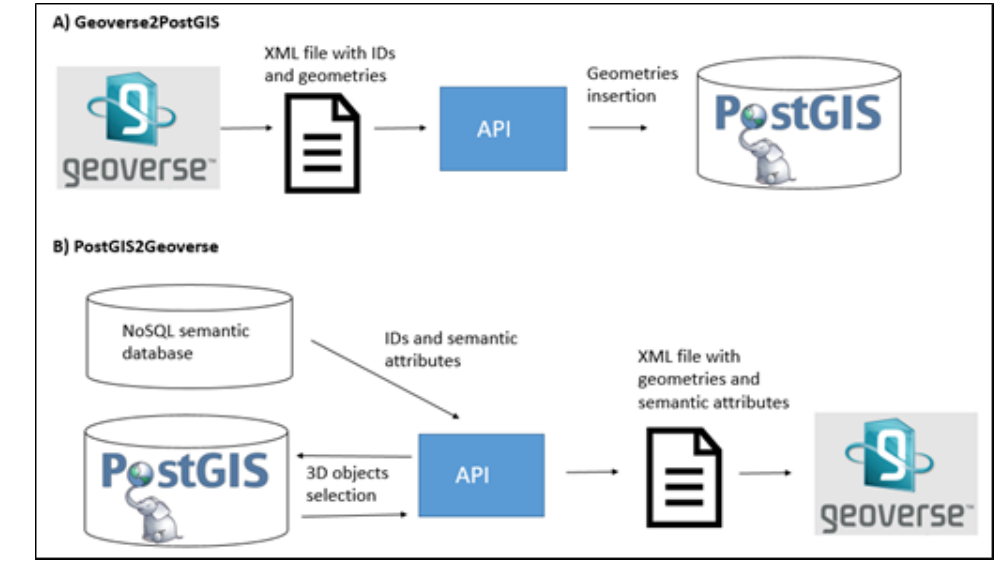
Figure 23. The spatial API scheme connecting Geoverse with PostGIS.